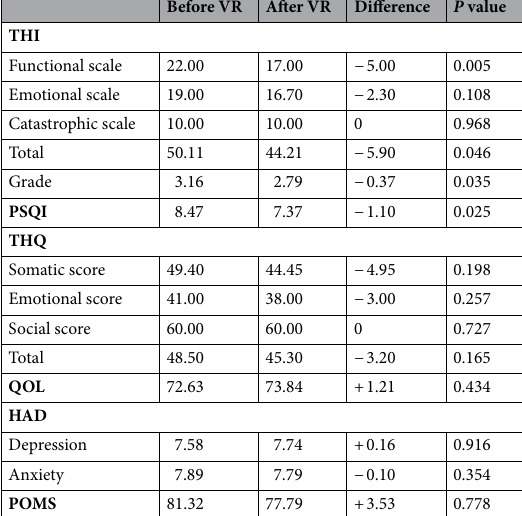
Table 3. Results of the questionnaires administered to the study participants. THI: Tinnitus Handicap Inventory; PSQI: Pittsburgh Sleep Quality Index; THQ: Tinnitus Handicap Questionnaire; WHO-QoL: World Health Organization Quality of Life assessment; HADS: Hospital Anxiety and Depression Scale; POMS: Profile of Mood States.